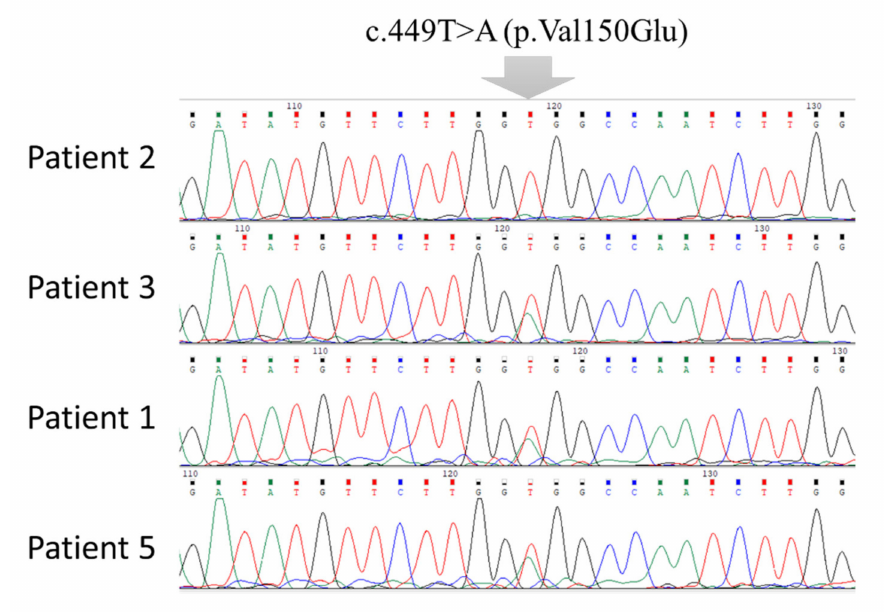
Figure 1. Representative chromatogram of the novel c.449T > A